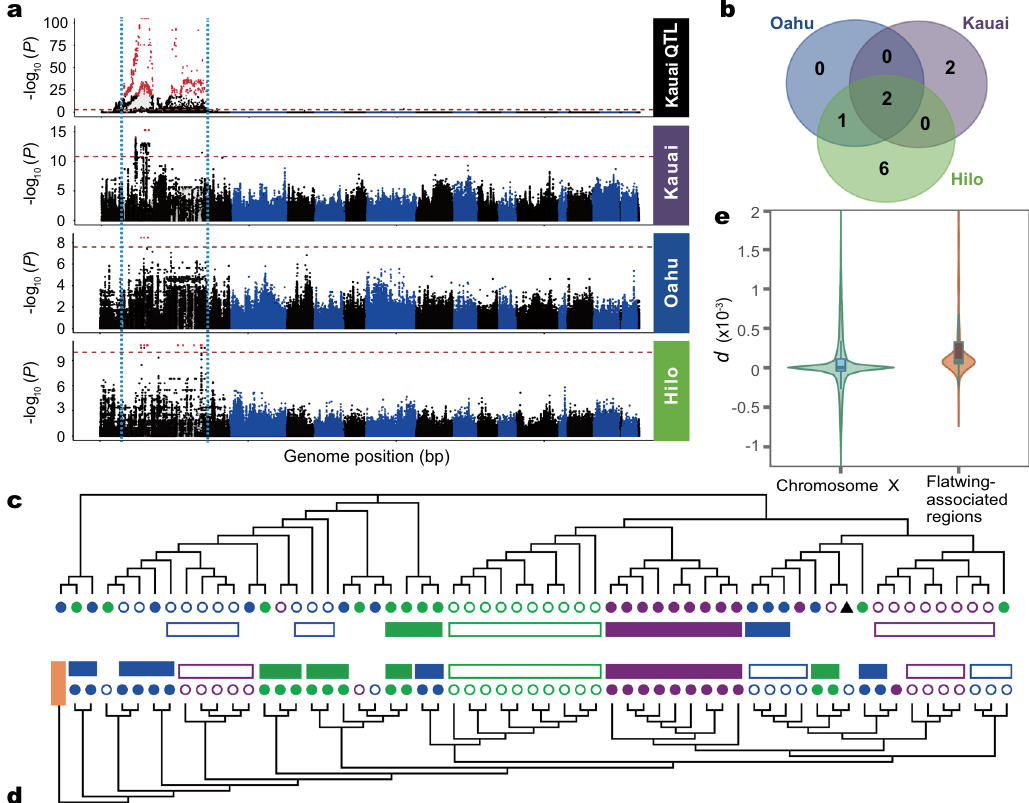
Fig. 3 Putative genomic hotspots containing different fl atwing-associated loci in cricket populations on three Hawaiian islands. a Flatwing association mapping. Data from a previously published fl atwing QTL 21 are shown on top, with red symbols showing fl atwing-associated SNPs and blue vertical lines the extent of the QTL on the X-linkage group (left-most block of black markers). Horizontal dashed lines indicate FDR-corrected signi fi cance thresholds, and alternating shades of black and blue indicate different linkage groups. For the lower three panels, the most signi fi cant markers are de fi ned as described in the main text using the strictest criterion and plotted in red. b Venn diagram showing candidate X chromosome scaffolds associated with the fl atwing phenotype for each population, all detected using the most stringent Oahu criterion. c Unrooted maximum-likelihood consensus tree for the two fl atwing- associated scaffolds shared by all islands. d Rooted maximum-likelihood consensus tree for all 1 kb fl anking regions of all fl atwing-associated SNPs. c , d Normal-wing males are represented with solid circles and fl atwing males with open circles. Clustered individuals ( ≥ 2) are highlighted using fi lled (normal- wing) and open ( fl atwing) boxes if they were from the same island population and shared the same wing phenotype. Black triangles represent the individual used as the reference genome 21 . Orange rectangle represents seven Australian individuals, which were used as an outgroup. e Violin plot of net genetic distance ( d ) outside and within fl atwing-associated regions on chromosome X between fl atwing Kauai and fl atwing Oahu samples. Distances were calculated in 10 kb sliding windows with 2.5 kb steps ( n = 66,211 and 437 windows, respectively). Values for upper quartile, median, and lower quartile, plus 1.5× interquartile ranges, are indicated with box plots in the middle of the violin plots. Additional statistical details are provided in Supplementary Fig.